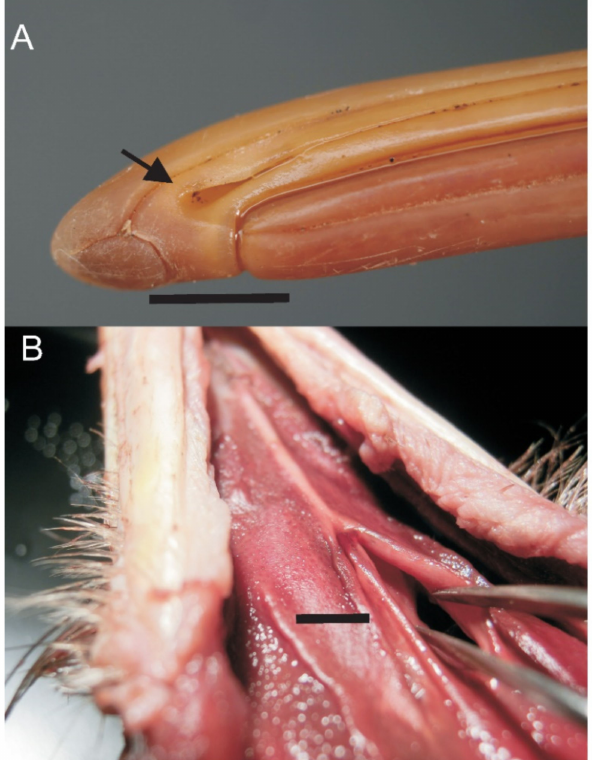
Figure 3. Apteryx mantelli . ( A ) external nares (arrow) ( B ) internal nares (in forceps). Scale bars = 1cm.